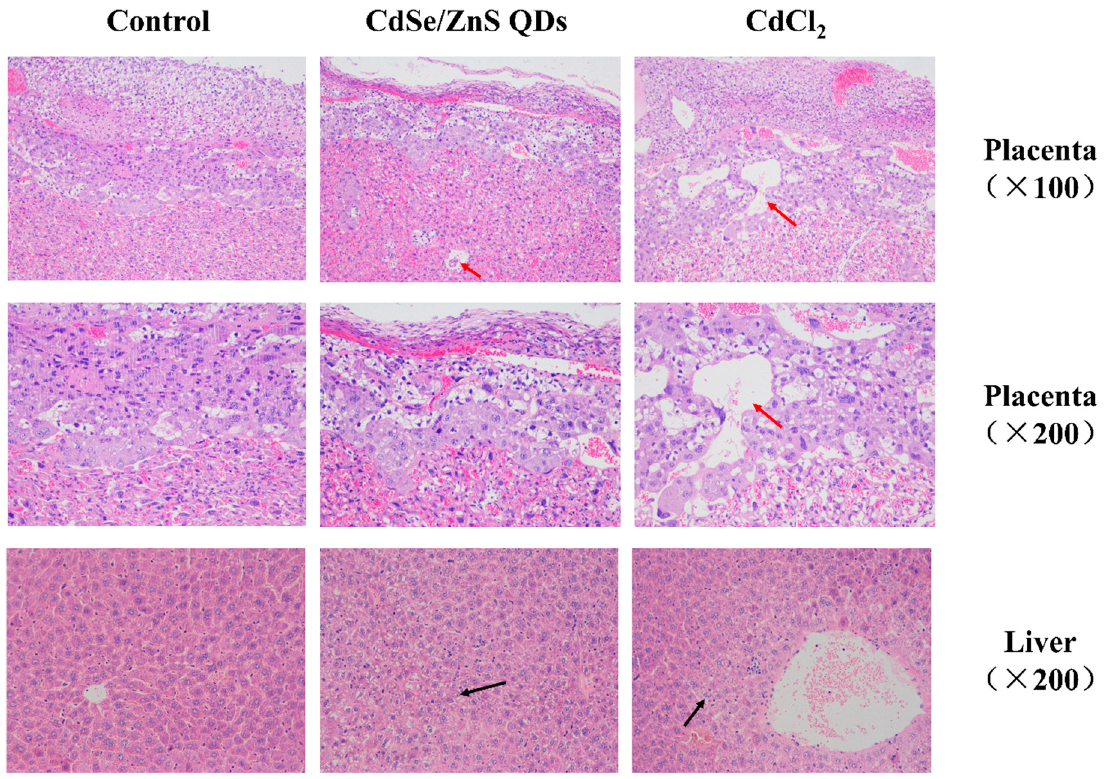
Figure 5. Histological images of the liver and placenta from GD18 P0 mice. Red arrows indicate the large vacuoles on placenta, black arrows indicate histopathological changes in the liver.